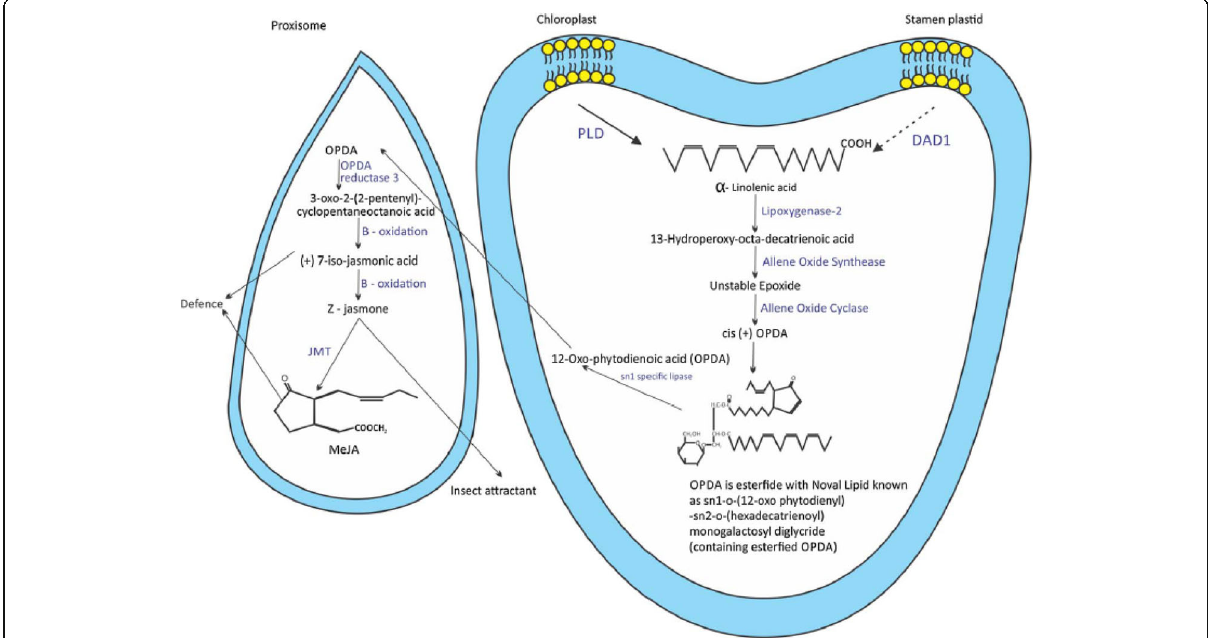
Fig. 2 Major steps involved in the synthesis of methyl jasmonates (MeJA) from α -linolenic acid (adopted from Per et al. 2018; re-drawn based on Wasternack and Song